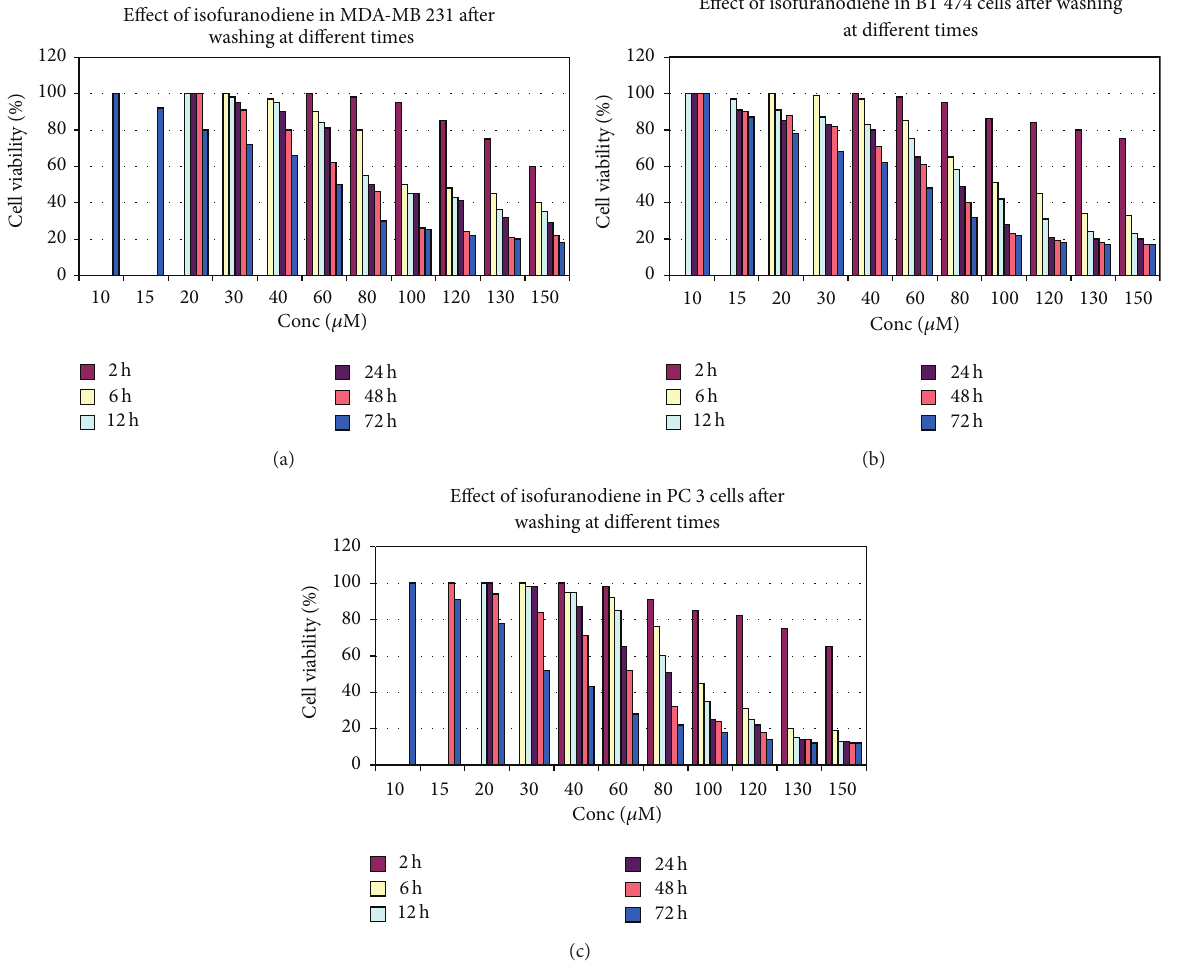
Figure 4: Cell viability assay in MDA-MB 231 (a), BT 474 (b), and PC 3 (c) cell lines expressed in percentage of cell survival after treatment with isofuranodiene at doses of 10–150 𝜇 M and at different incubation times (2, 6, 12, 24, 48, and 72 h). After incubation, isofuranodiene was washed out with PBS, and fresh drug-free medium was added. Analysis was performed after 72 h in all the cell lines; results are reported as (viability of treated cells)/(viability of control cells) × 100 and represent the average of three independent experiments with a maximum SD lower than ± 8.0.